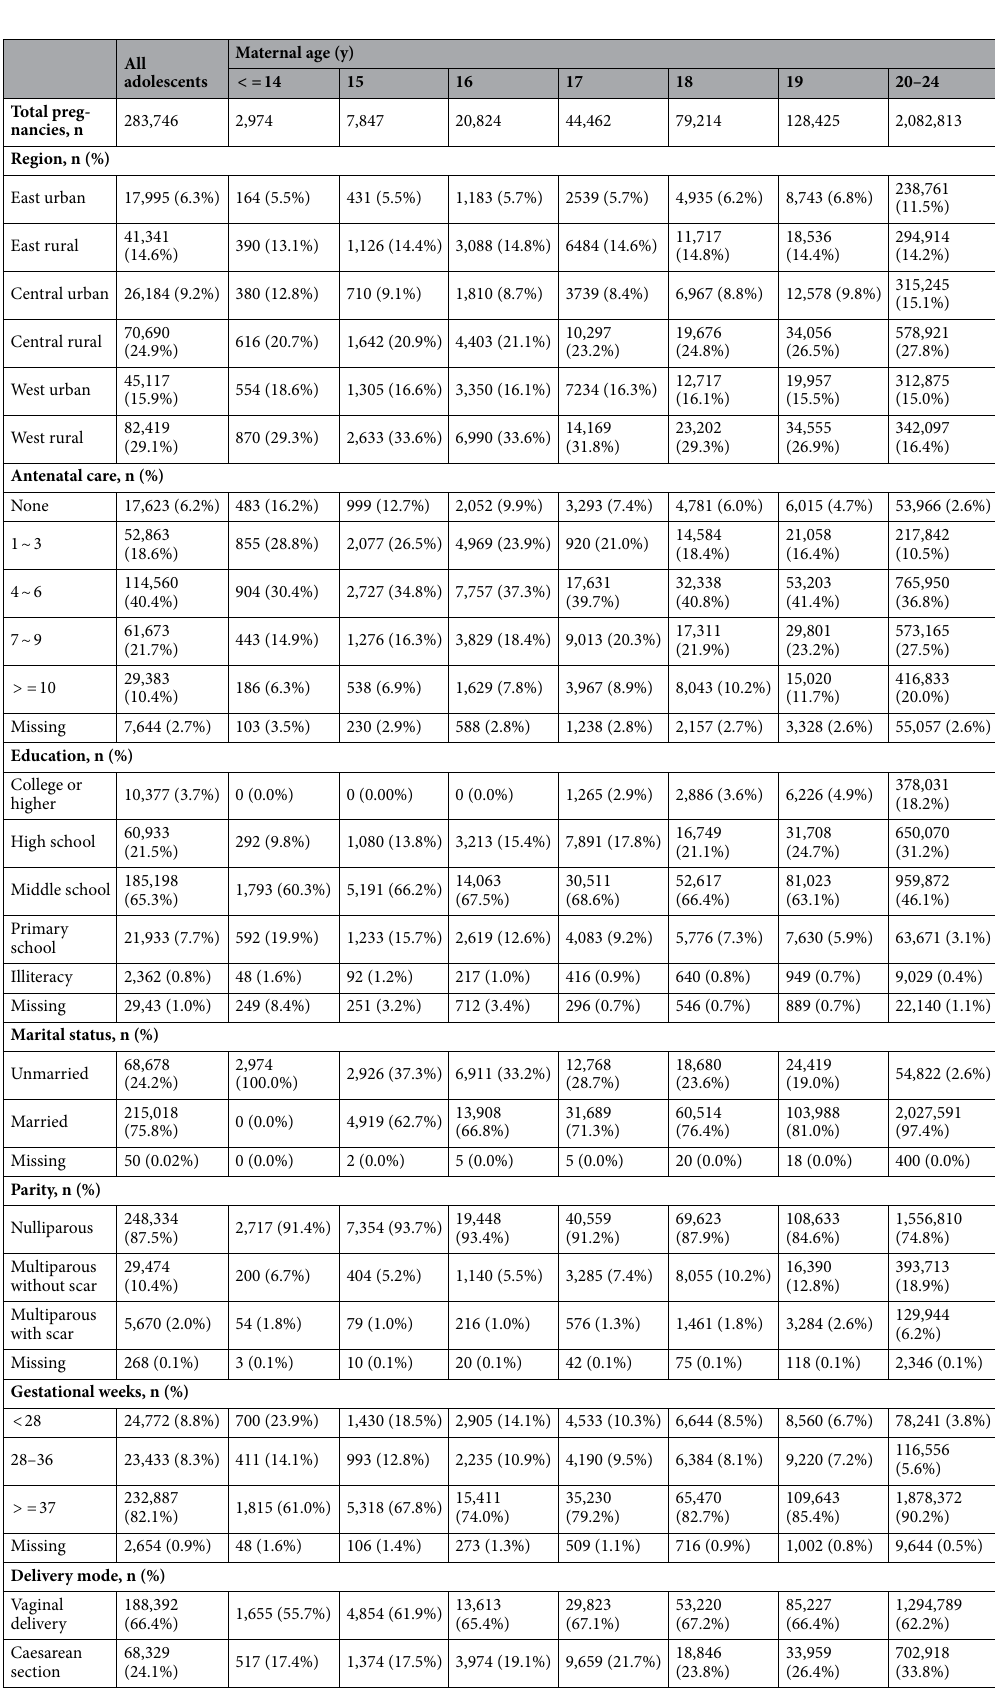
Table 1. Maternal characteristics and delivery information in relation to maternal age (< 25 years old) in China,